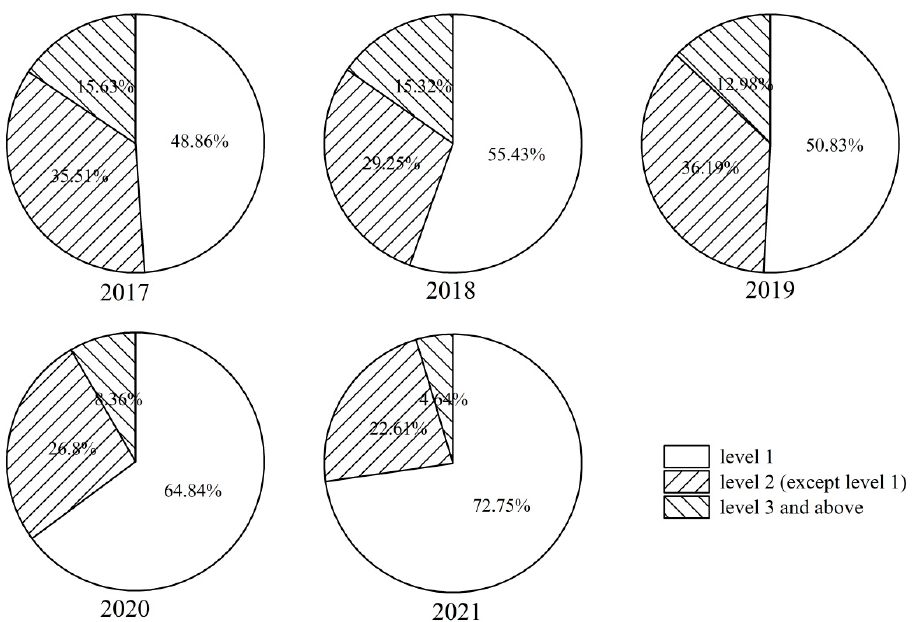
Figure 3. The proportion of days of different levels of environmental air quality during the period 2017 – 2021.